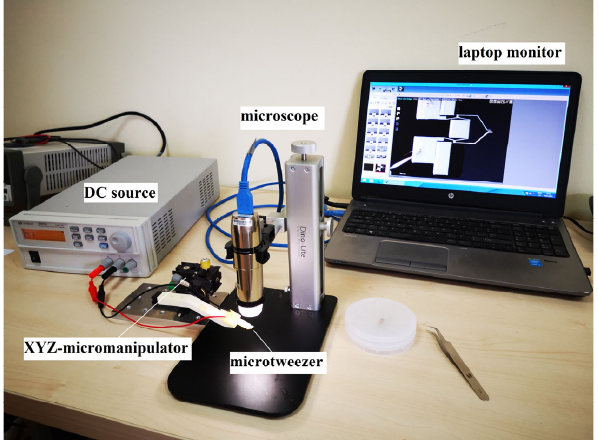
Figure 13. The experimental setup for micromanipulation applications.